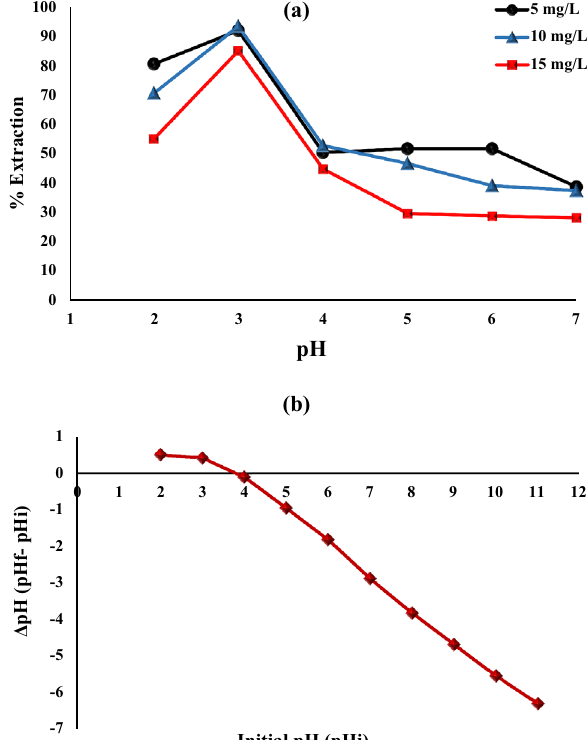
Figure 7. ( a ) Impact of initial pH on the removal of Cr(VI) by Fe 0.75 Cu 0.25 -BDC@Alg-MoO 3 /GO ( b ) PZC plot.